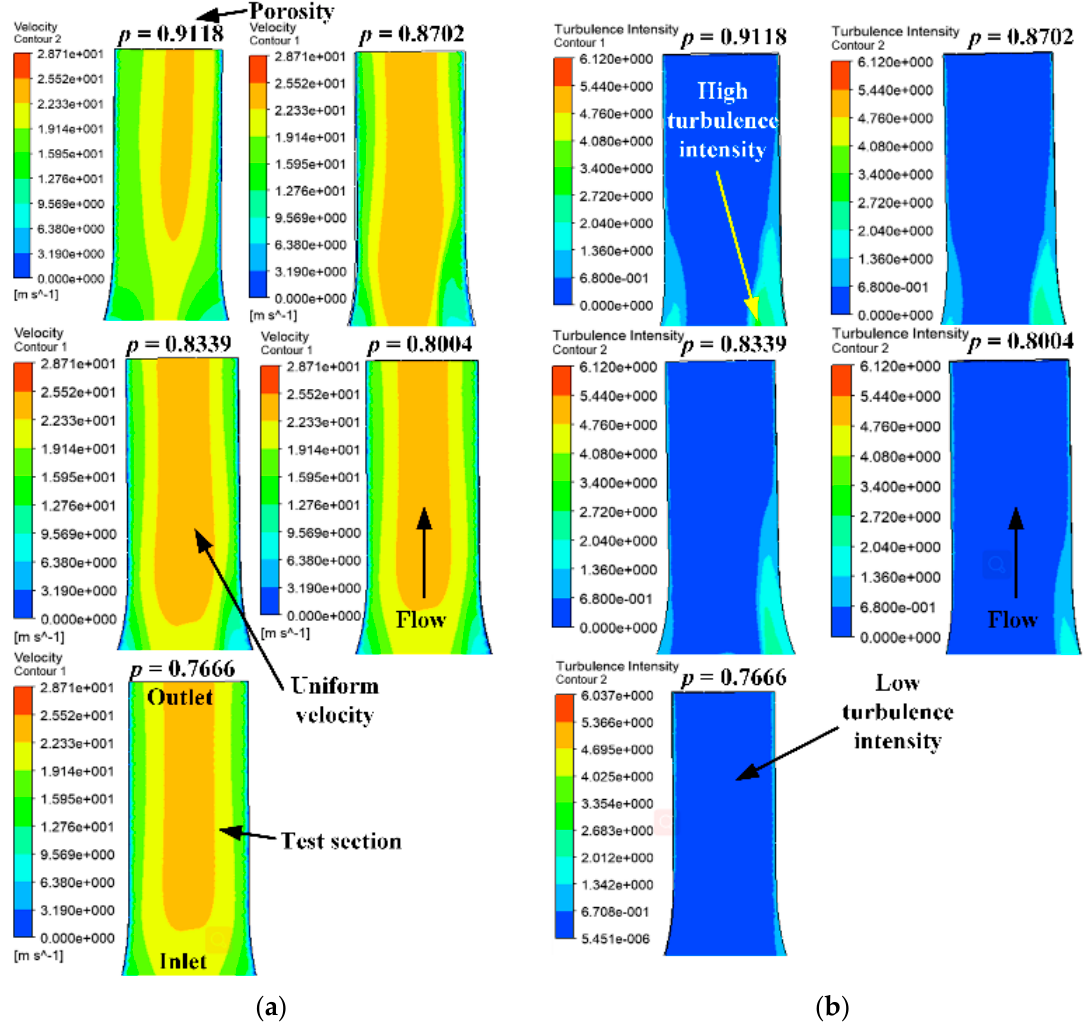
Figure 9. Velocity contour ( a ) and the turbulence intensity contour ( b ) at different honeycomb porosities.